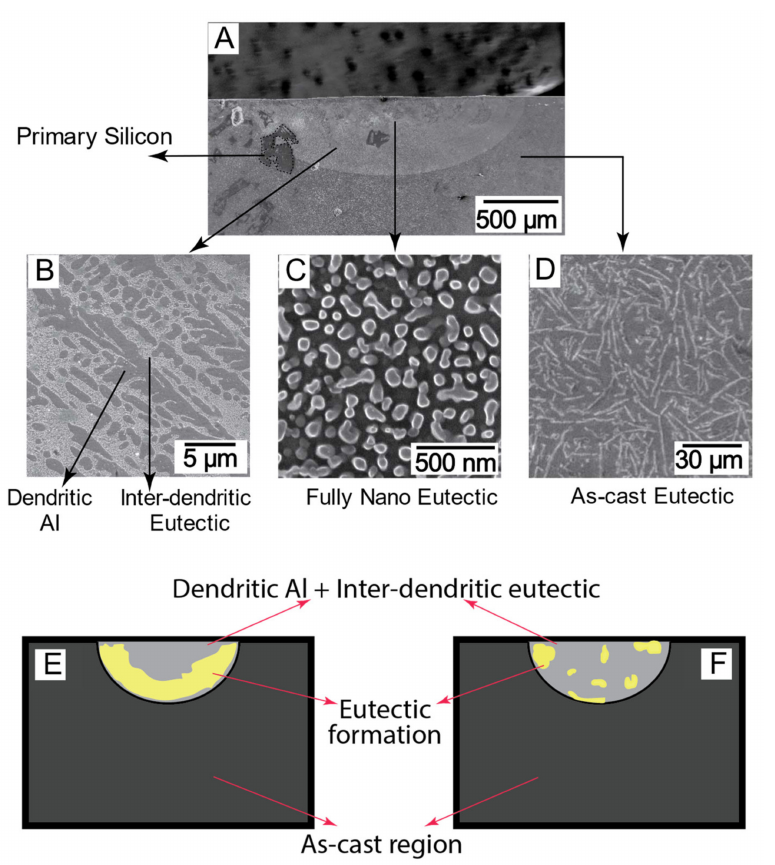
Figure 2. Microstructures of LSR Al-20Si alloys under SEM ( A ) and a schematic. ( A ) The melt pool formation right after the experiment was shown; hemi-spherical melt pool and surrounding non-heat-affected zone could be seen. (The cut off line and background carbon tape with some dark patterns were advised to be disregarded.) The microstructure quantification reported corresponds to ( B ) Al dendrite formation and interdendritic eutectic structure with fibrous Si in the LSR region. ( C ) Fully eutectic colony within LSR region, with fibrous Si. ( D ) As-cast flake eutectic. Schematic of the eutectic structures observed within the melt pools. ( E ) Continuous and discernable fully eutectic regions. ( F ) Random, inter-dendritic eutectic regions within primary Al dendrites with pockets of fully eutectic regions.